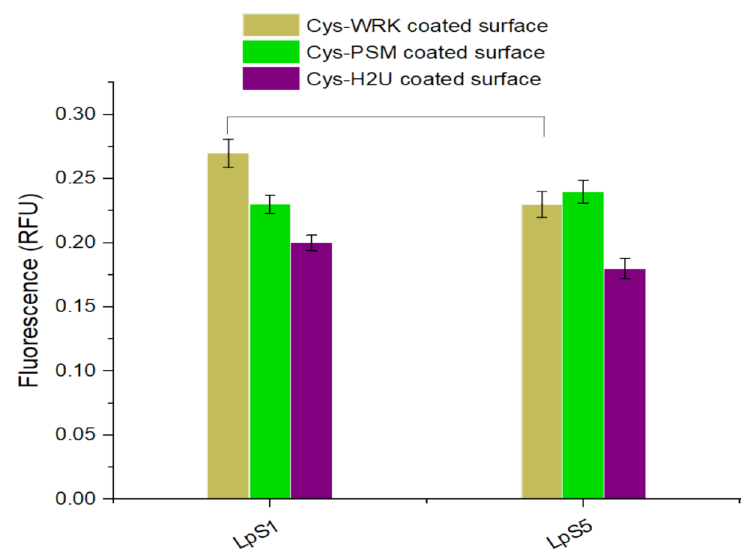
Figure 4. Quantitative PCR results (relative fluorescence units, RFU) for L. pneumophila SG1 and L. pneumophila SG5 captured by peptide-functionalized biosensors. Error bars represent standard error of the mean from three separate experiments. Statistical differences were measured by 2-way ANOVA followed by Tukey’s multiple comparison test with L. pneumophila serogroups and coatings as variables affecting amplification of the mip gene. The horizontal lines between bars indicate significantly different values between serogroups ( p <